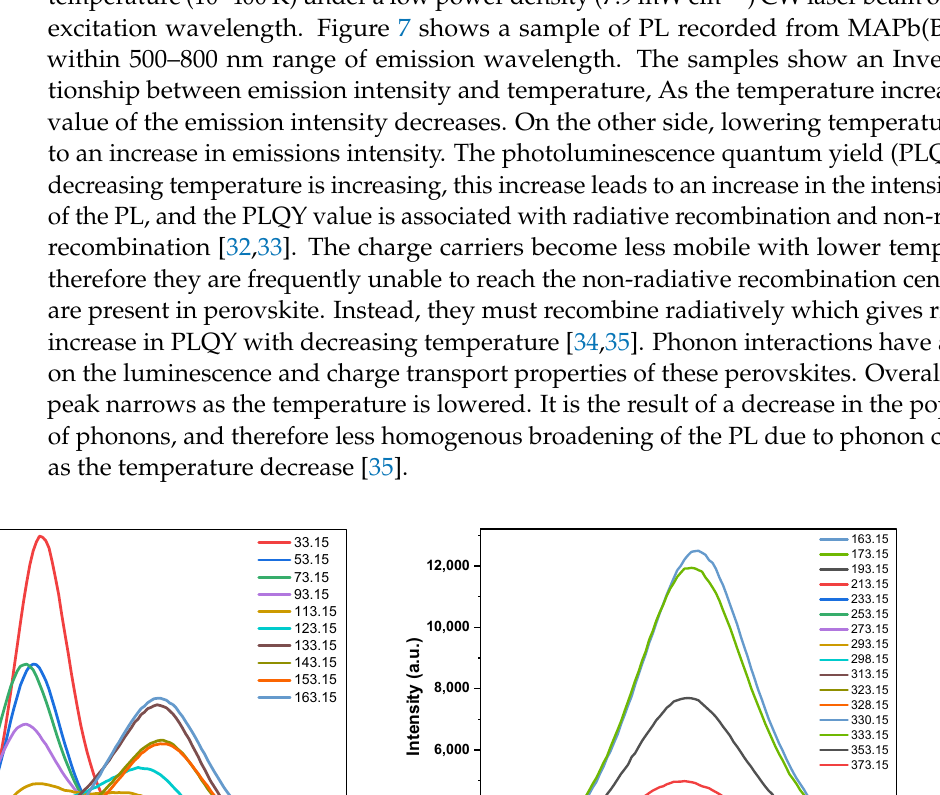
Figure 6. The Photoluminescence spectra of MAPb(Br x I 1 − x ) 3 perovskite films. 3.3. Temperature-Dependent of Phase Structure and PL for MAPb(Br x I 1 − x ) 3 Perovskites Temperature-dependent PL of MAPb(Br x I 1 − x ) 3 has been studied over a wide range of temperature (10–400 K) under a low power density (7.9 mW cm − 2 ) CW laser beam of 473 nm